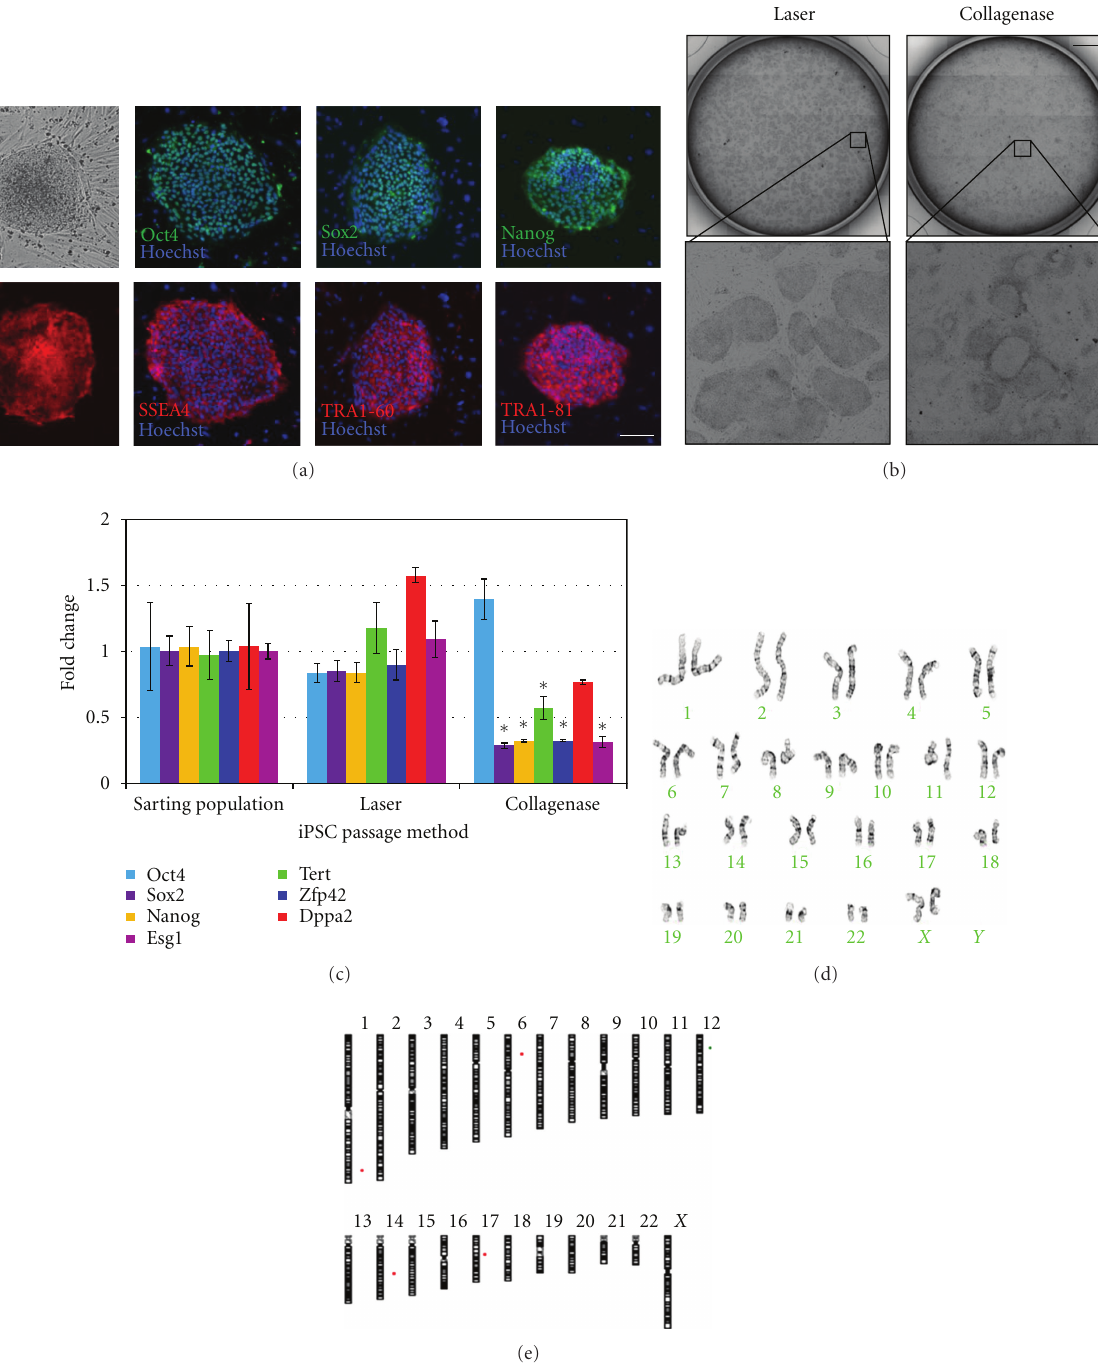
Figure 4: Pluripotency and stability of stem cells after laser-mediated passage. (a) Colony morphology (brightfield, BF) and immunocytochemical analysis of Oct4, Sox2, Nanog, alkaline phosphatase (AP), SSEA4, TRA1-60, and TRA1-81 expression in human ESCs (H9) after 24 consecutive laser-mediated passages. Hoechst was used as a nuclear counterstain. Scale bar, 250 μ m. (b) Whole well brightfield images of human iPSC (BIMR 6) cultures after 10 consecutive laser-mediated passages or collagenase passages. Scale bar, 5mm. (c) QRT- PCR analysis of stem-cell-associated gene expression in iPSCs (BIMR 6) after 10 consecutive laser-mediated passages or collagenase passages. The asterisks ( ∗ ) indicate values that are statistically significant compared with the starting population of iPSCs. The data are presented as mean ± s.d. ( n = 3). Statistical analysis was performed using t -test, with a P value ≤ 0.05 considered to be significant. (d) Normal karyotype of H9 human ESCs after 24 laser-mediated passages (6 months). (e) Schematic depicting genomic abnormalities of H9 ESCs at P35 (starting population) and at P59, after 24 laser-mediated passages (6 months), as determined by aCGH. No new subkaryotypic abnormalities were detected after 24 passages. Red bars indicate a deletion. Green bars indicate an amplification. See Table 1 for complete list of aberrations found in these